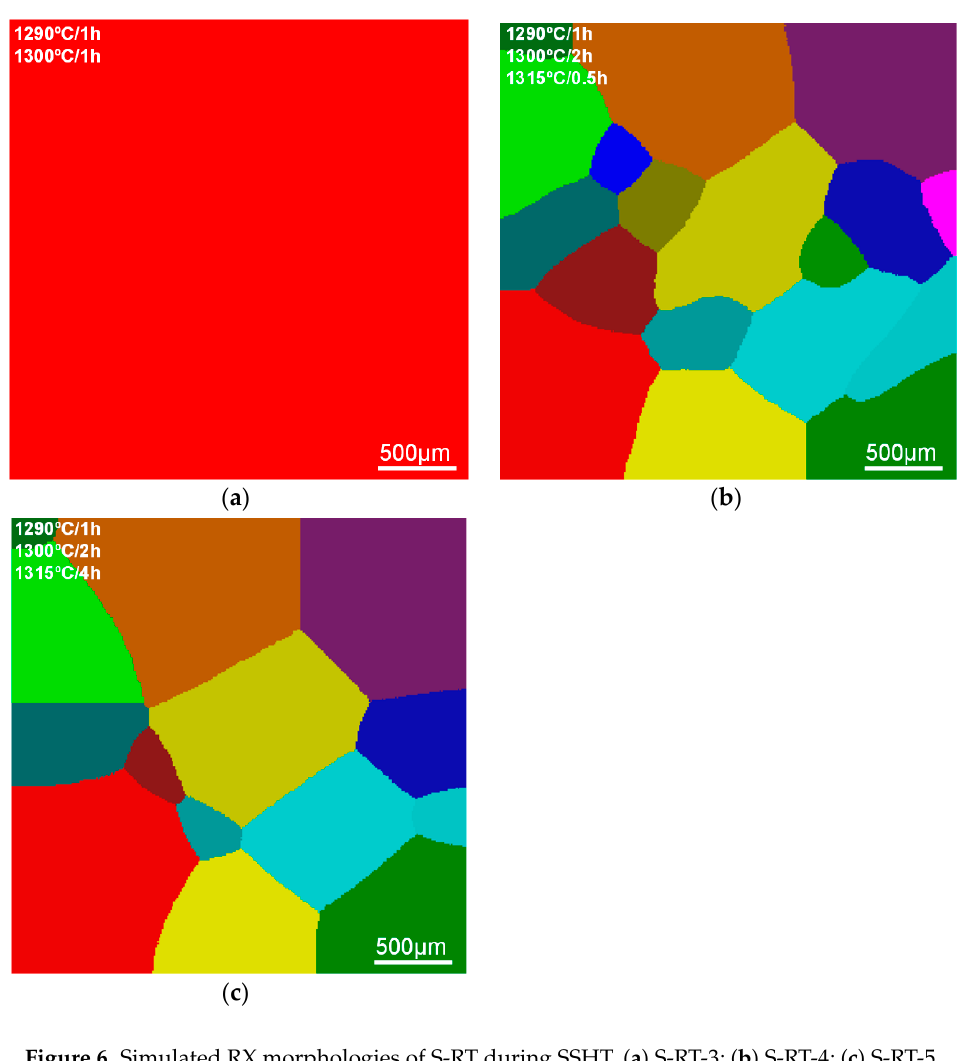
Figure 6. Simulated RX morphologies of S-RT during SSHT. ( a ) S-RT-3; ( b ) S-RT-4; ( c ) S-RT-5.